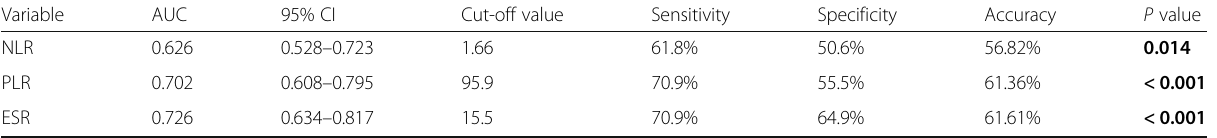
AS, ankylosing spondylitis; AUC, area under curve; CI, confidence interval; ESR, erythrocyte sedimentation rate; NLR, neutrophil/lymphocyte ratio; PLR, platelet/ lymphocyte ratio; P value, probability value